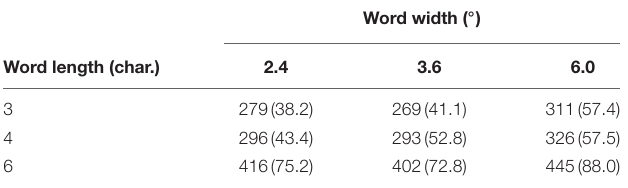
TABLE 2 | Average threshold exposure durations in Experiment 2